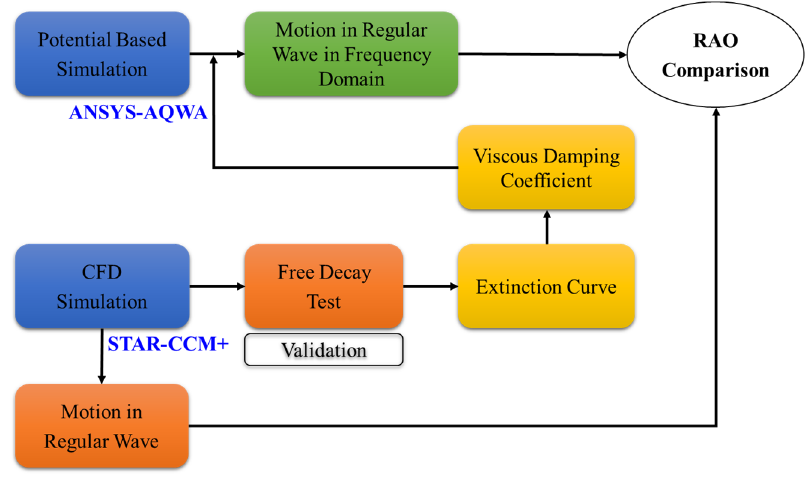
Figure 3. Scope and process of present study.